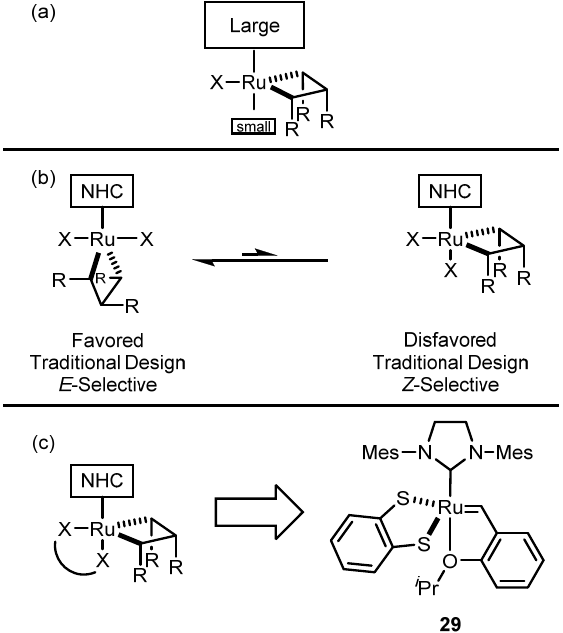
Figure 8. Design process for 29 . ( a ) Mimicking the design of the Mo and W Z -selective catalyst; ( b ) Observations showing the bottom-bound ruthenacycle is favored; ( c ) Employing a bidentate chelate that would induce a side-bound ruthenacyclobutane.